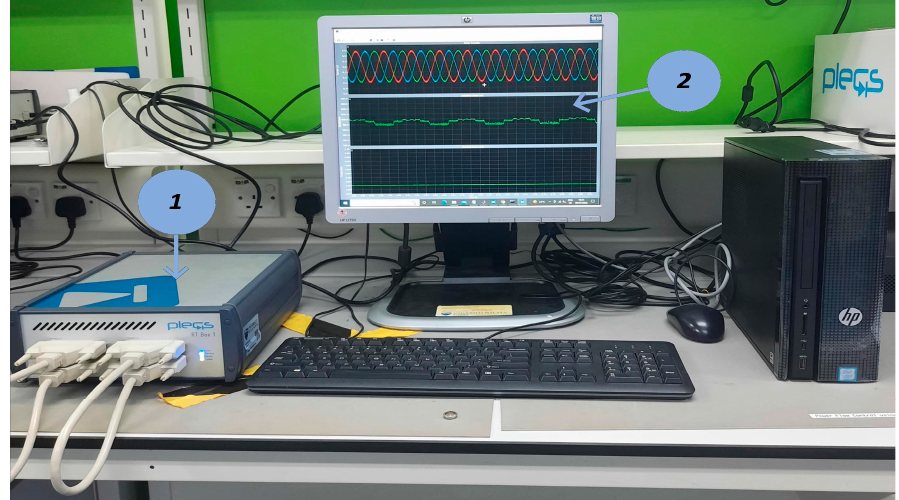
Figure 7. Hardware in ‐ the ‐ loop experimental setup. (1) PLECS RT ‐ box, (2) desktop.